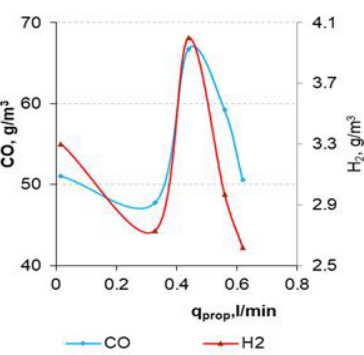
Figure 1. Principal schematic of the batch size pilot setup for gasification and co-firing of straw pellets with propane: 1 – gasifier of biomass pellets; 2 – primary air supply nozzle; 3 – water-cooled sections; 4 – propane flame injection nozzles; 5 – secondary air supply nozzle; 6 – orifices for diagnostic tools.